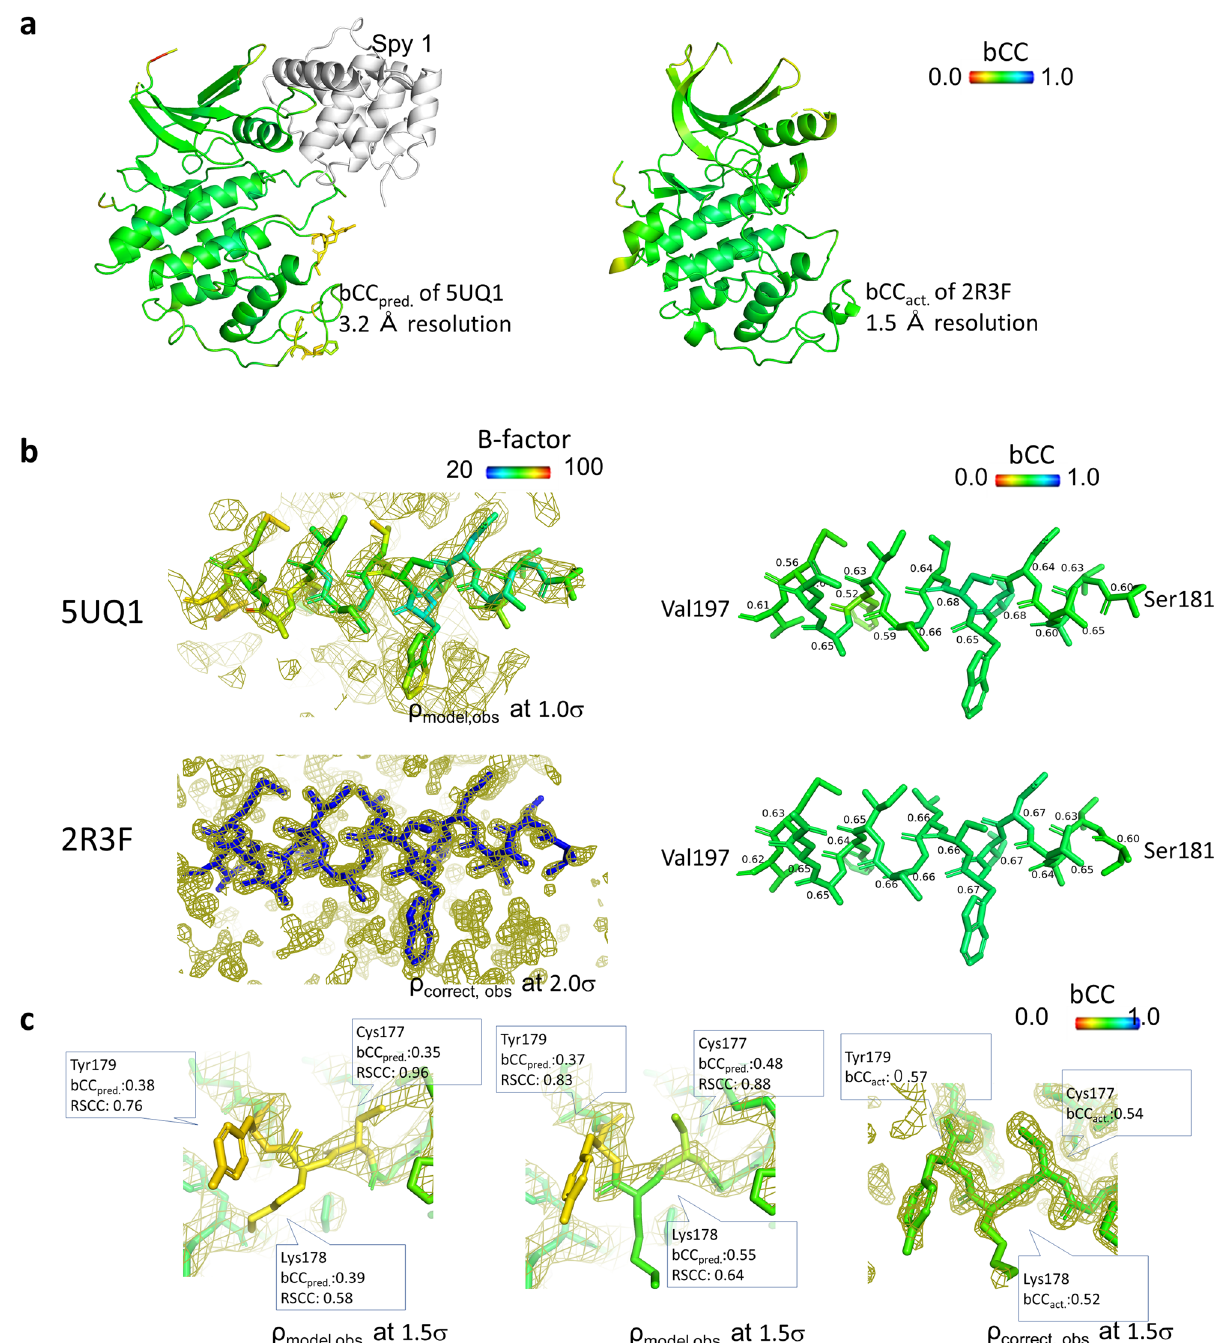
Figure 6. Comparison between high- and low-resolution structures of CDK2. ( a ) The whole structures 5UQ1 (3.2 Å resolution; complexed with Spy1) with bCC pred. and 2R3F (1.5 Å resolution) with bCC act. in rainbow color. ( b ) The same a helix from Ser181 to Val195 in 5UQ1 (above) and 2R3F (below). Despite the electron density and B-factors varying between the two structures because of the resolution (left), bCC pred. for 5UQ1 and bCC act. for 2R3F are consistent (right; bCC values are shown). It means the accuracy of the coordinates can be predicted independent of resolution. ( c ) 5UQ1’s bCC pred. is lower than 2R3F’s bCC act. from Cys177 to Tyr179. The electron density is unclear because of the loop region, and the direction of the carbonyl at Lys178 cannot be determined based on the electron density. Because bCC pred. of Lys178 is low at 0.39, it was modified in the same direction as 2R3F, which improved bCC pred. , predicting that the modification was